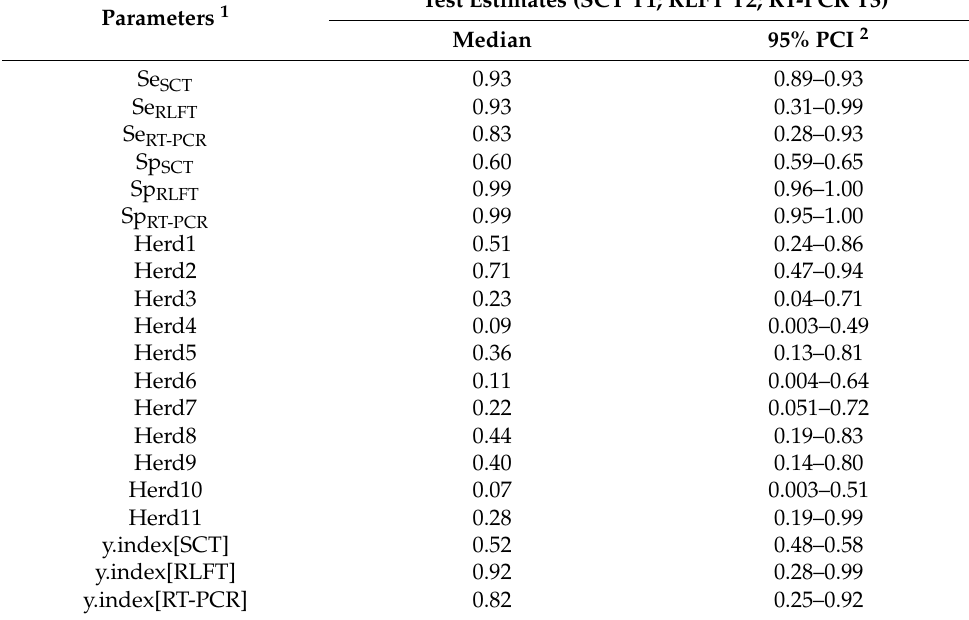
Table 3. Test estimates of three diagnostic tests (single cervical tuberculin test (SCT), rapid lateral-flow test (RLFT) and Real-Time PCR (RT-PCR)) for diagnosis of bovine tuberculosis in dairy cattle ( n = 245) from 11 Egyptian cattle